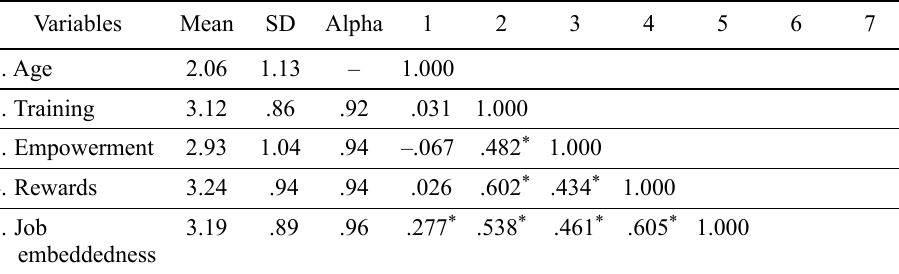
Table 2. Scale reliabilities, means, standard deviations, and correlations of study variables